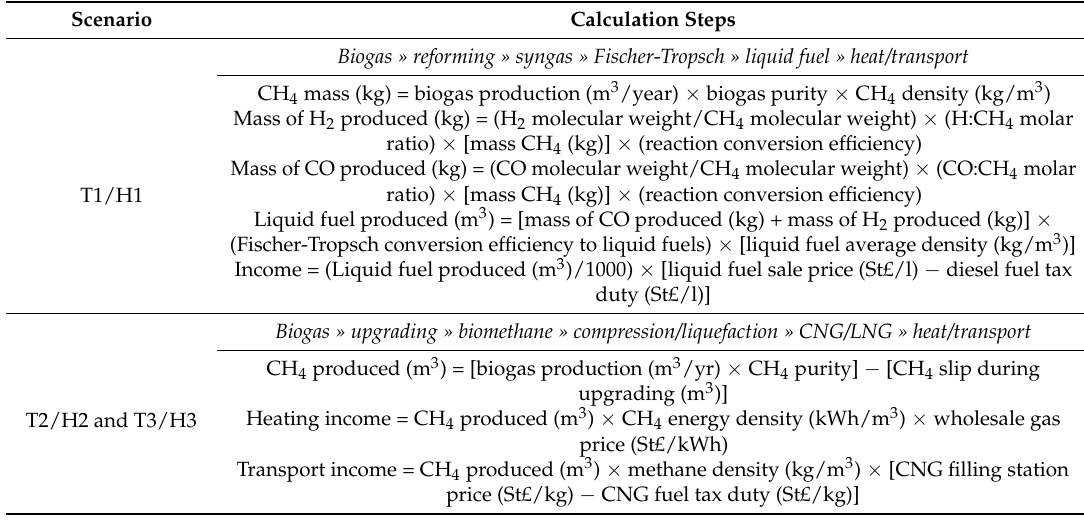
Table 7. Income calculation methodology for the investigated routes in the heat and transport sectors excluding the Renewable Heat Incentive (RHI).